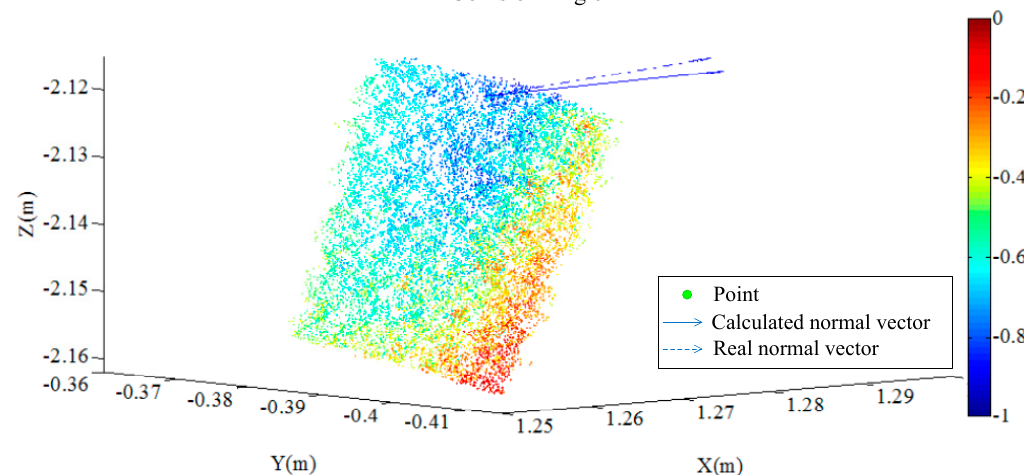
Figure 6. Comparison of the calculated and actual normal vectors.